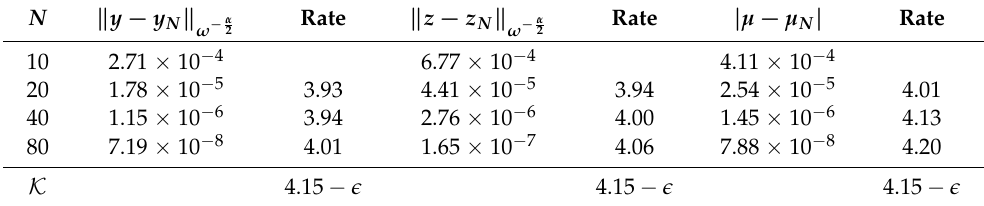
Table 3. Errors and convergence rates of y , z in weighted L 2 norm and µ with α = 1.70. N